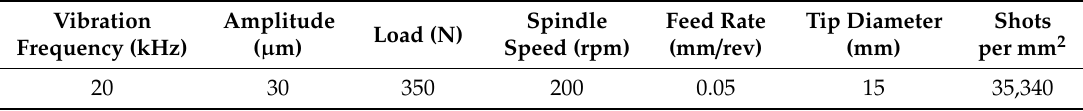
Table 2. Ultrasonic surface rolling processing (USRP) treatment